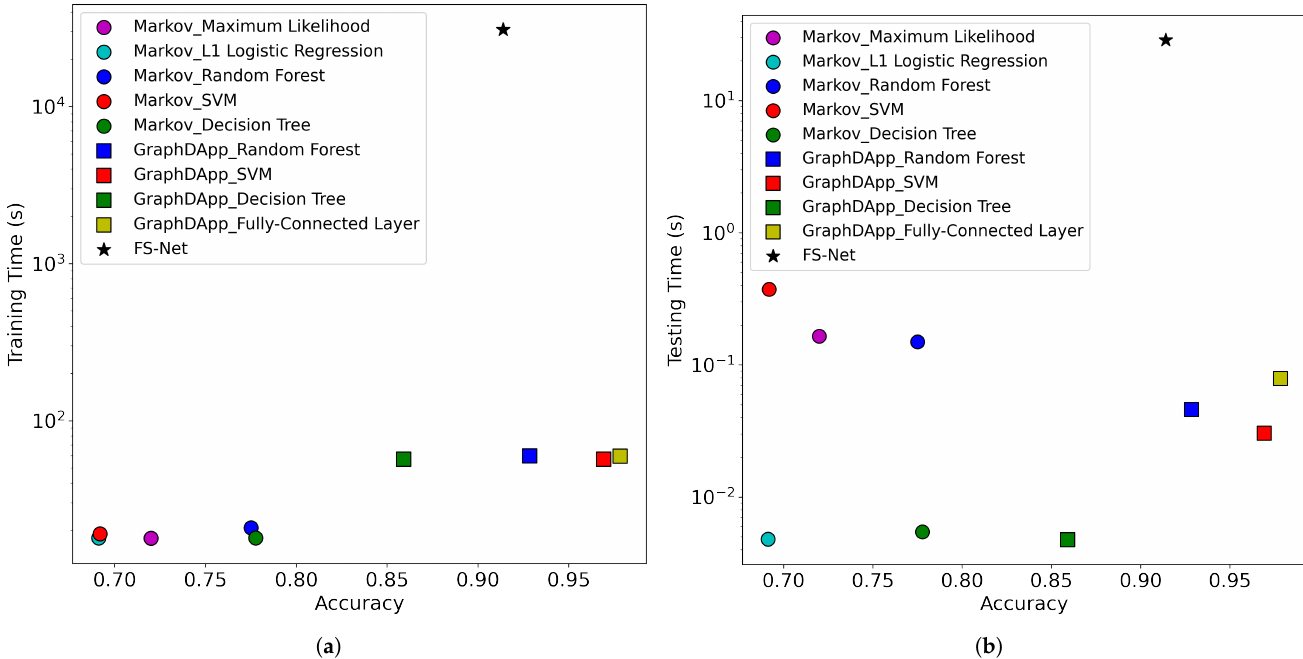
Figure 8. Training and testing time of malware family classifiers used in evaluation. ( a ) Training time. ( b ) Testing